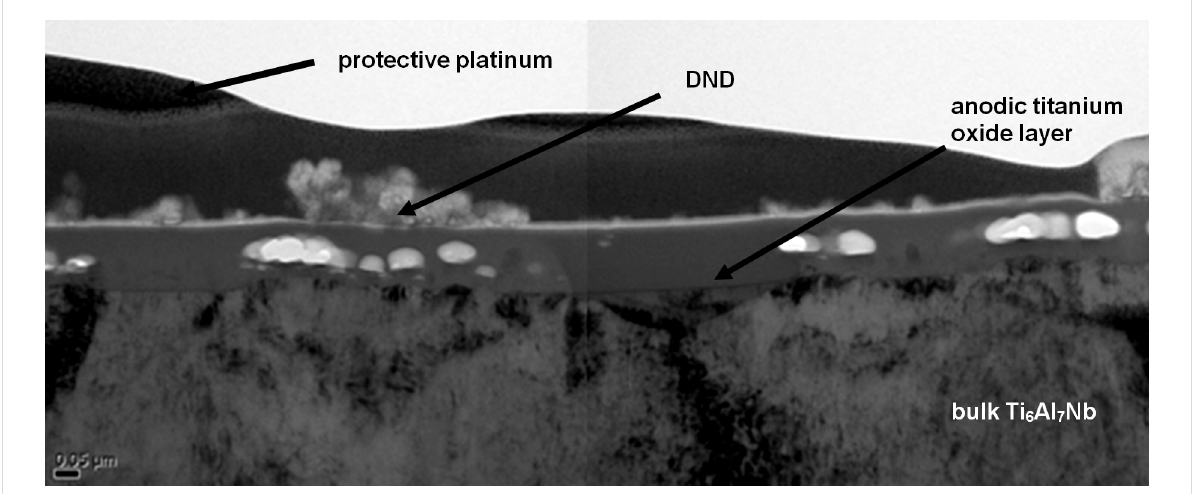
Figure 5: STEM image of immobilized aminosilanized DND 6 adsorbed to the air-formed passive layer of Ti 6 Al 7 Nb sample followed by anodic polarization (60 V, 50 mA/cm 2 ).